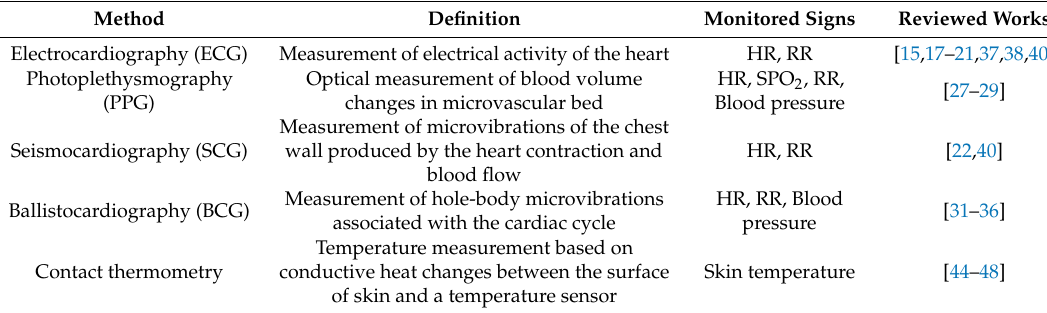
Table 2. Vital signs monitoring